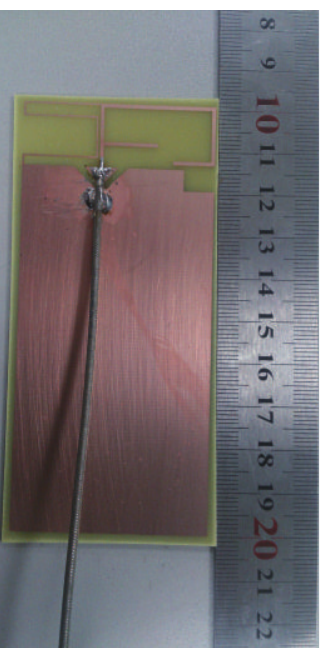
Figure 11, the impedance matching around 2050 MHz and 2550 MHz is better than that around 2400 MHz. Figure 9: Fabricated prototype of the proposed